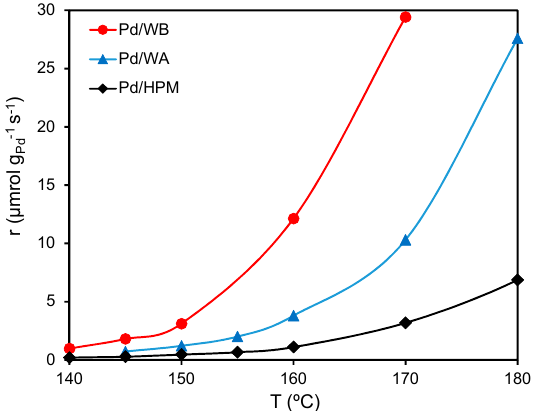
Figure 7. Catalytic performance of the monolithic catalysts normalized per gram of Pd in the m -xylene combustion ([ m -xylene] = 0.10 vol.%, Q = 2000 m 3 gas h − 1 m − 3 monolith ). Figure adapted with permission from [60]. Copyright 2008,